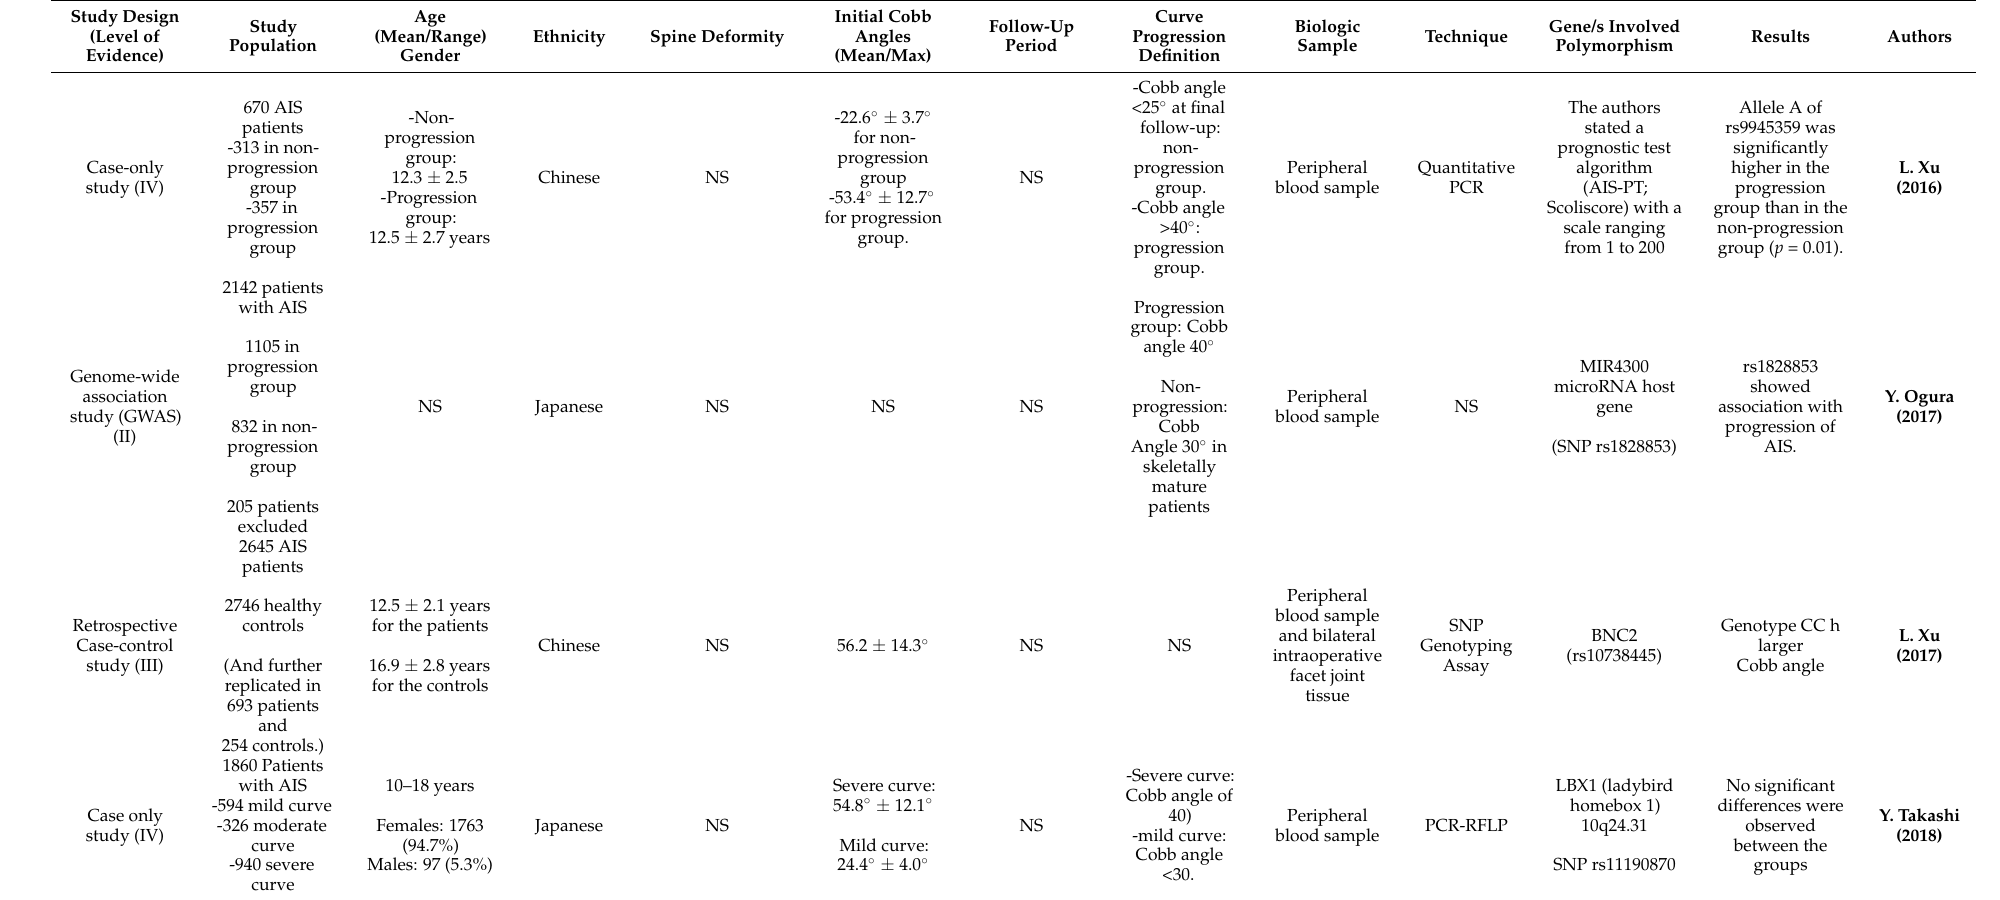
Mild curve: 24.4 ◦ ± 4.0